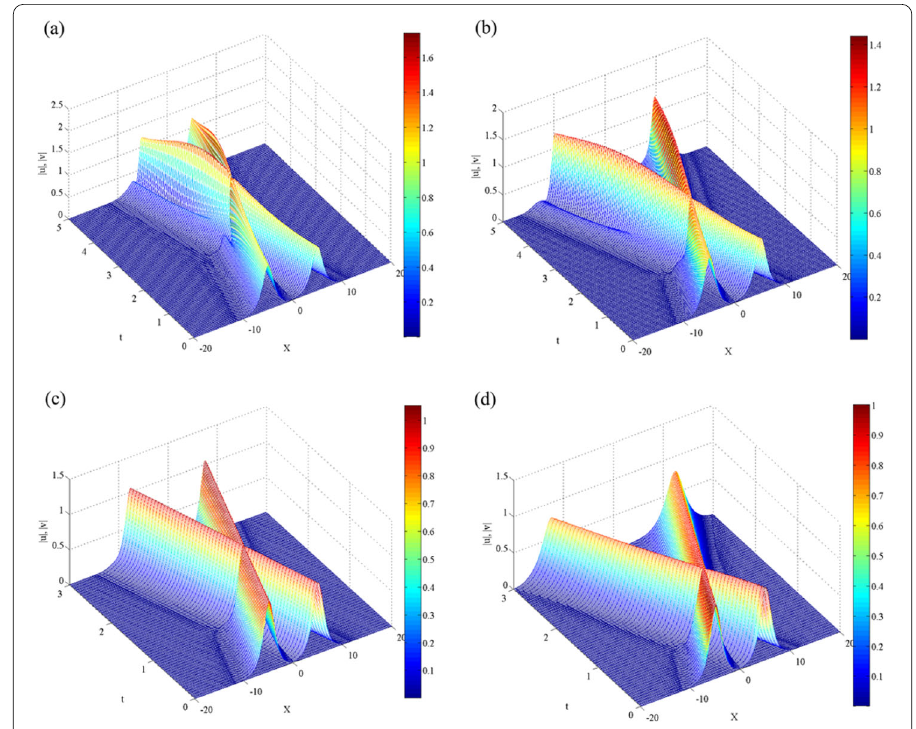
Figure 3 The interactions of two solitons for different α with λ = ρ = 1; ( a ): α = 0.7, ( b ): α = 0.8, ( c ): α = 0.9, ( d ): α = 1